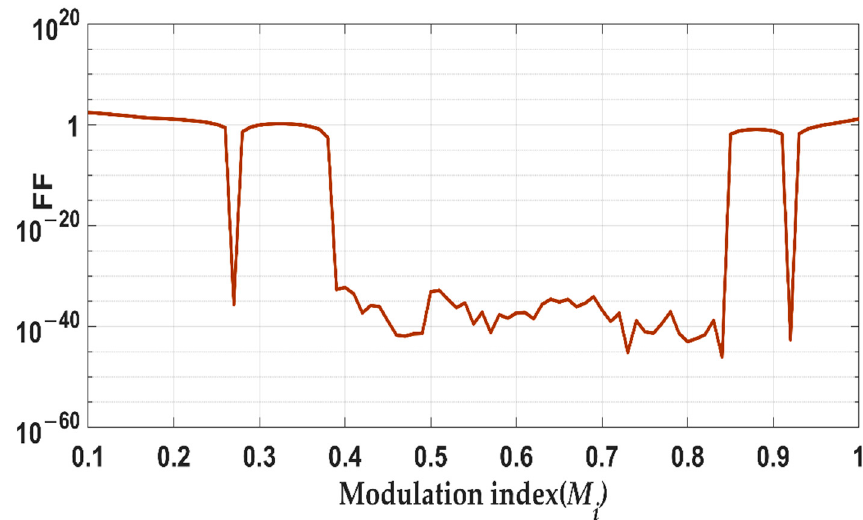
Figure 9. Fitness value for MPA versus modulation index.